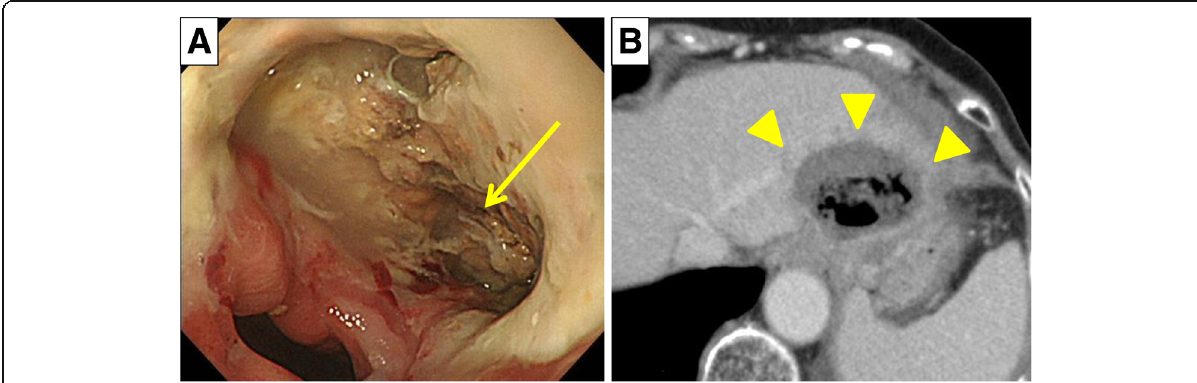
Fig. 3 a Upper gastrointestinal endoscopy revealed perforation of the esophagus, and an ablated area of the liver was observed via the hole (arrow). b Contrast-enhanced computed tomography revealed that the cavity was localized due to severe adhesion (arrow